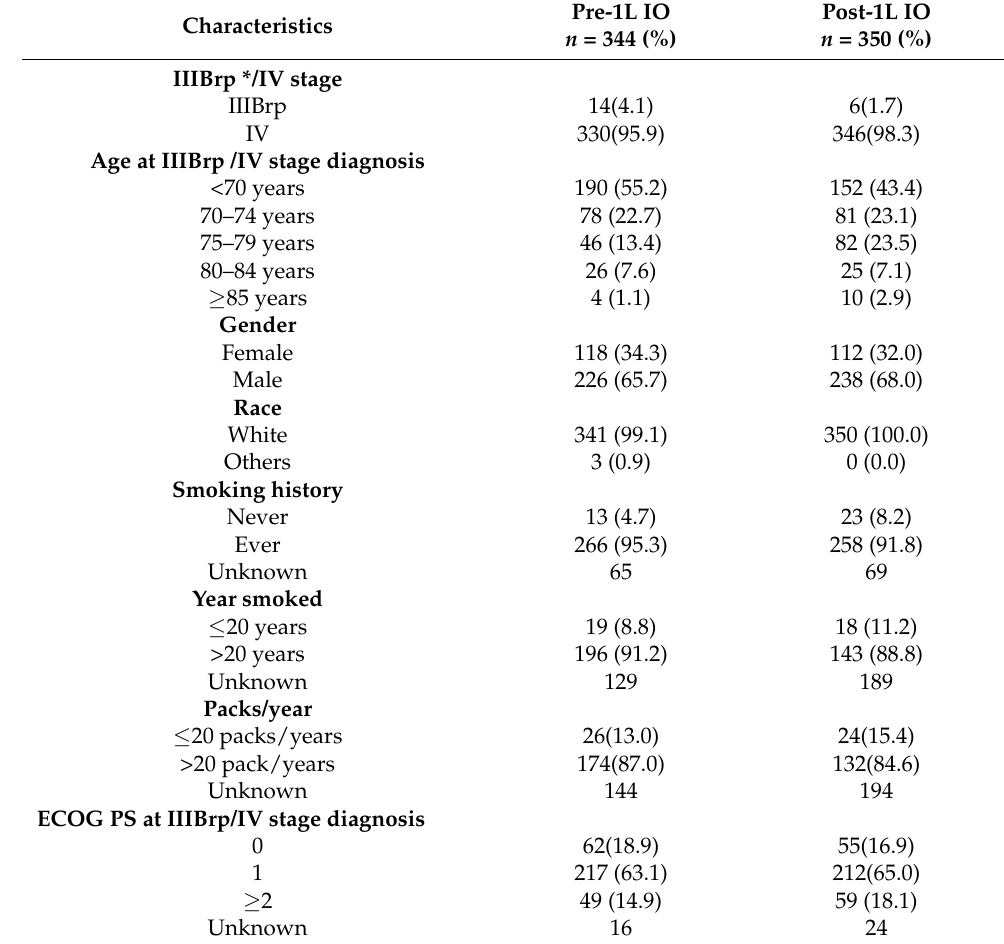
Table 1. Baseline demographic and clinical characteristics of patients by Pre- and Post-1L IO groups.